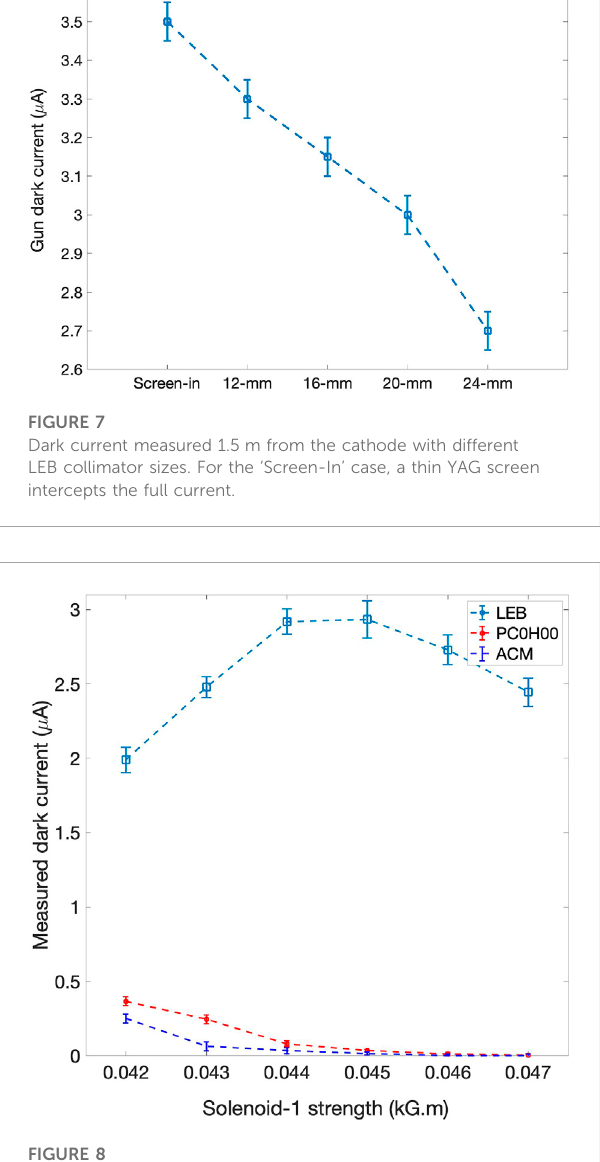
FIGURE 8 Measured dark current at the 20-mm LEB collimator and the PC0H00collimator,andthedarkcurrenttransportedthroughanACM as function of the strength of Solenoid-1.